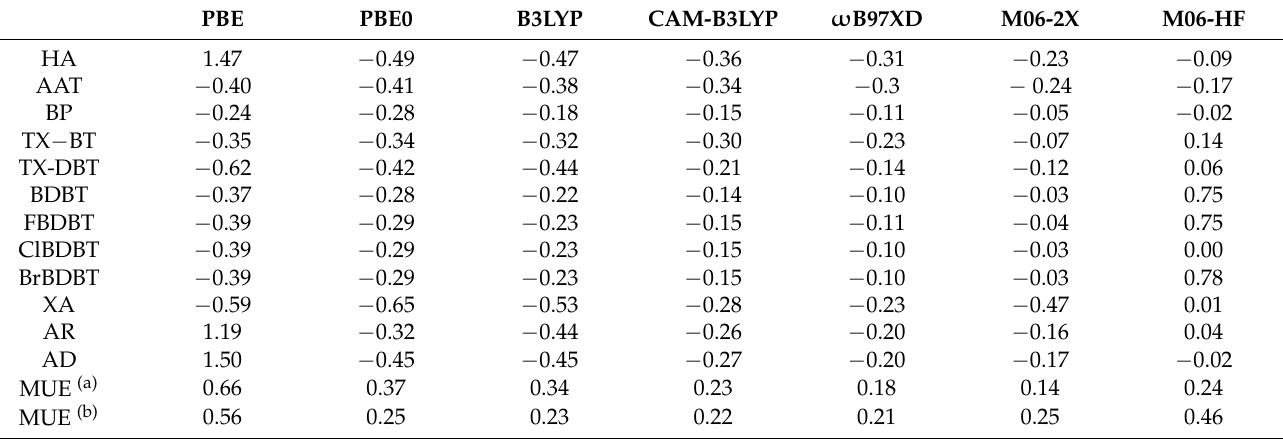
Table 3. The energy differences ∆ E (in eV ) relative to the CC2 for the phosphorescence energy of AQs, as calculated by U//UDFT with the different functionals (PBE, PBE0, B3LYP, CAM − B3LYP, ω